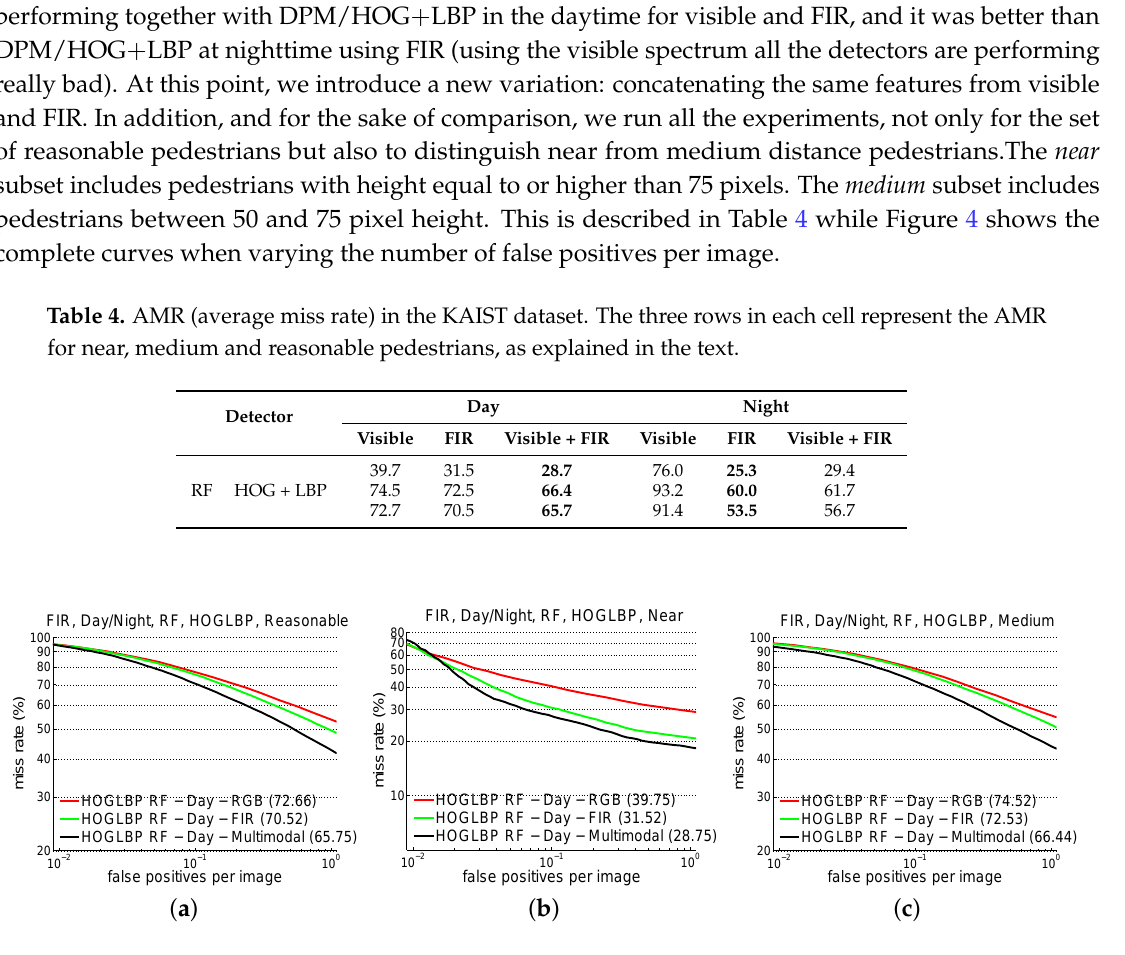
Figure 4. Results using different test subsets over KAIST multispectral dataset during daytime. Results obtained with RF/HOG + LBP for ( a ) reasonable ( b ) near and ( c ) medium pedestrian